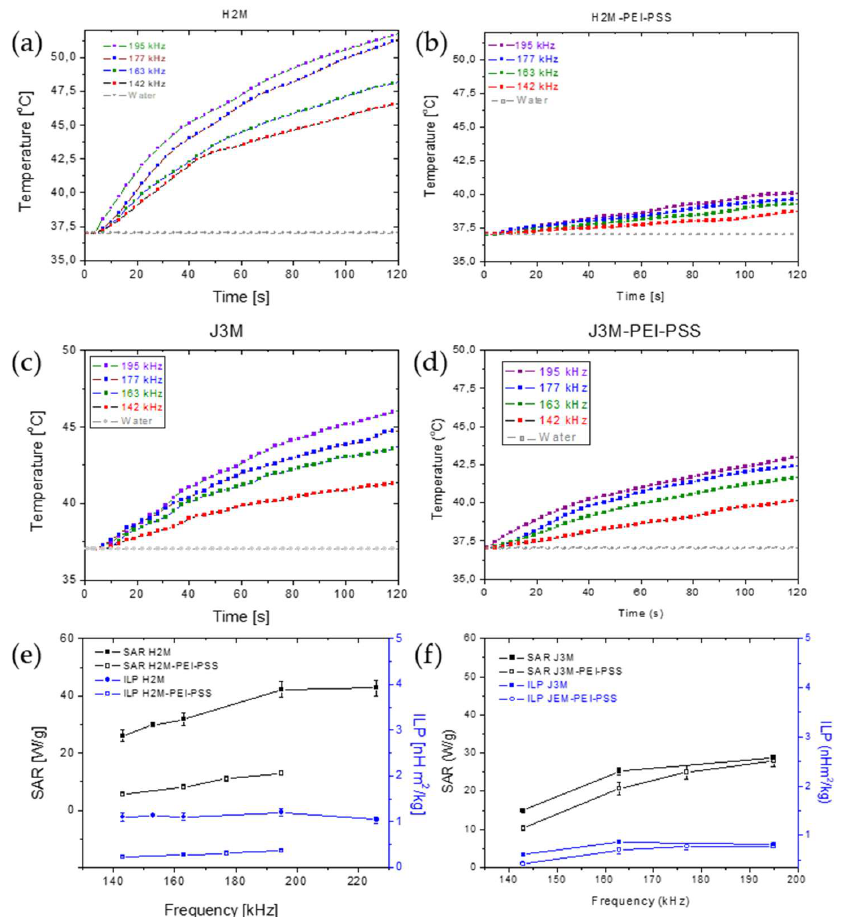
Figure 4. Hyperthermia response tests: temperature-time curves of uncoated and coated magnetic MNRs ( a – d ). SAR and ILP values vs. frequency ( e , f